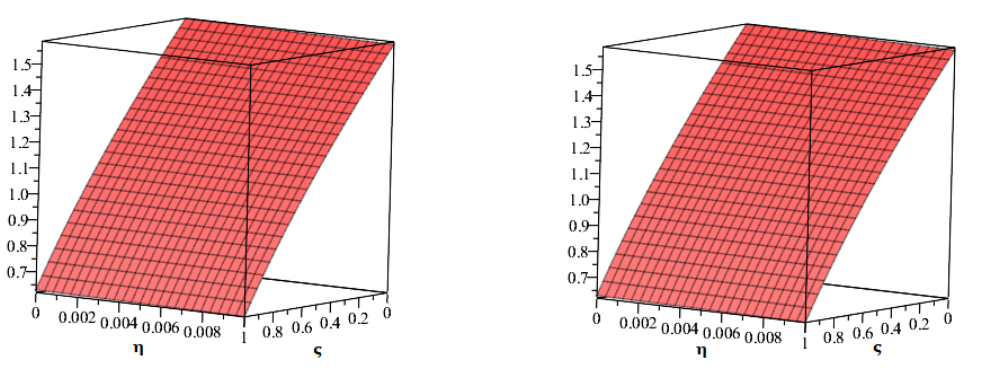
Figure 7. The proposed method solution and accurate solution at γ = 1.